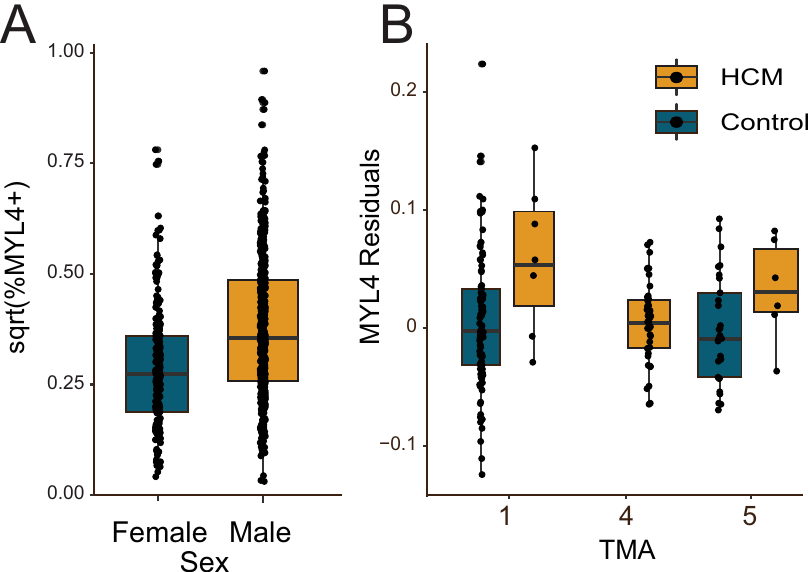
Figure 2. MYL4 + mosaicism by gender and disease. ( A ) Male subjects had more MYL4 + cells, independent of disease state (p = 8.66e-15). ( B) In left ventricular segments, MYL4 + cells were increased in HCM compared to control tissues (TMAs 1&5). There were no control septal tissues to compare to the HCM cases on TMA4. The MYL4 residual is of a regression of sqrt(%MYL4 + ) cells adjusted for multiple measures per individual and effects of different TMAs, age, and sex.